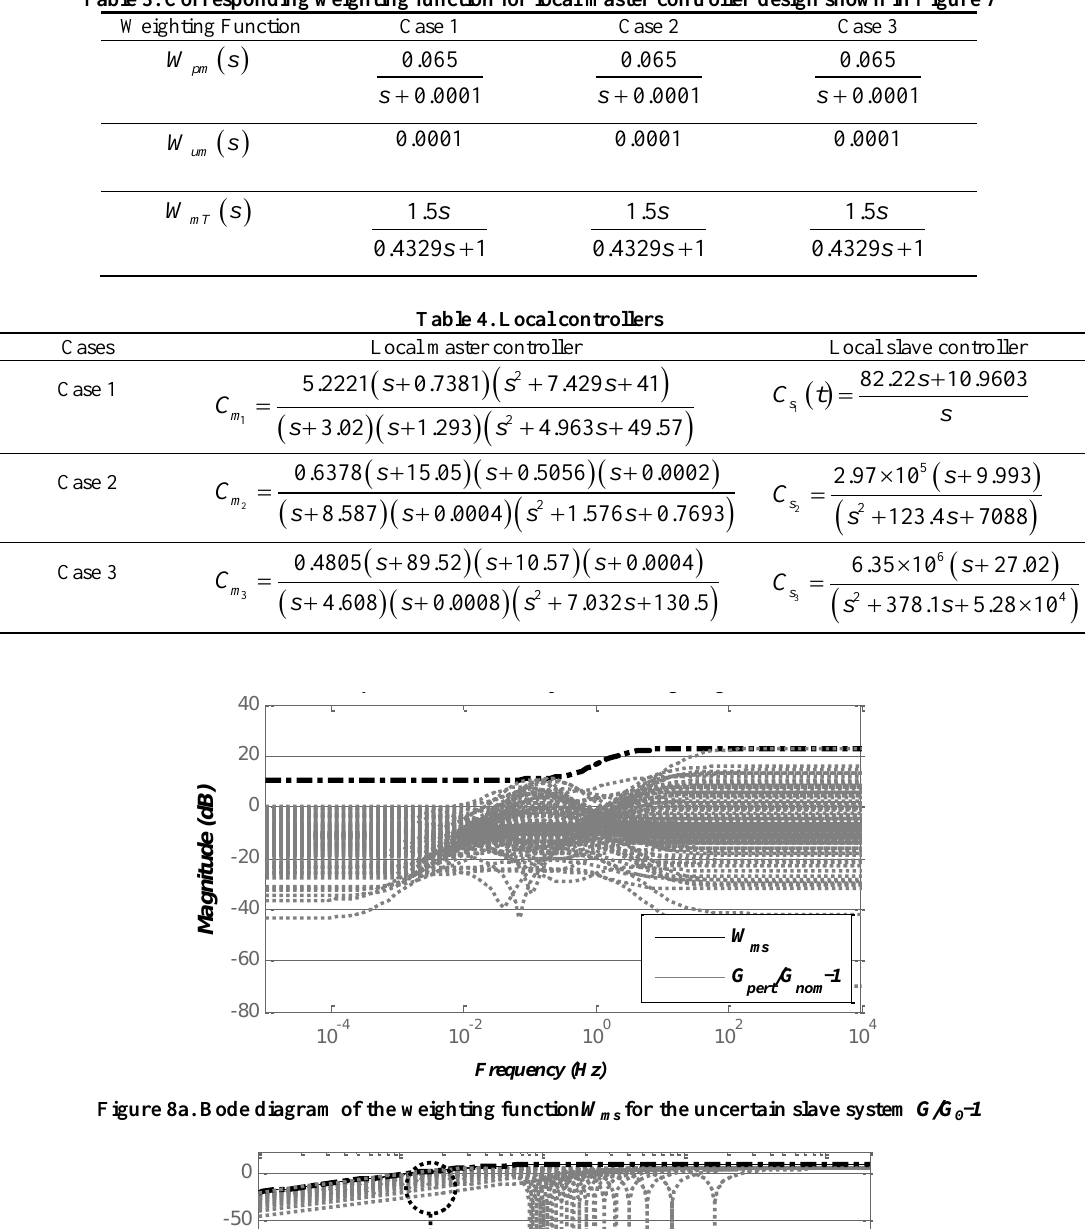
Table 3. Corresponding weighting function for local master controller design shown in Figure 7